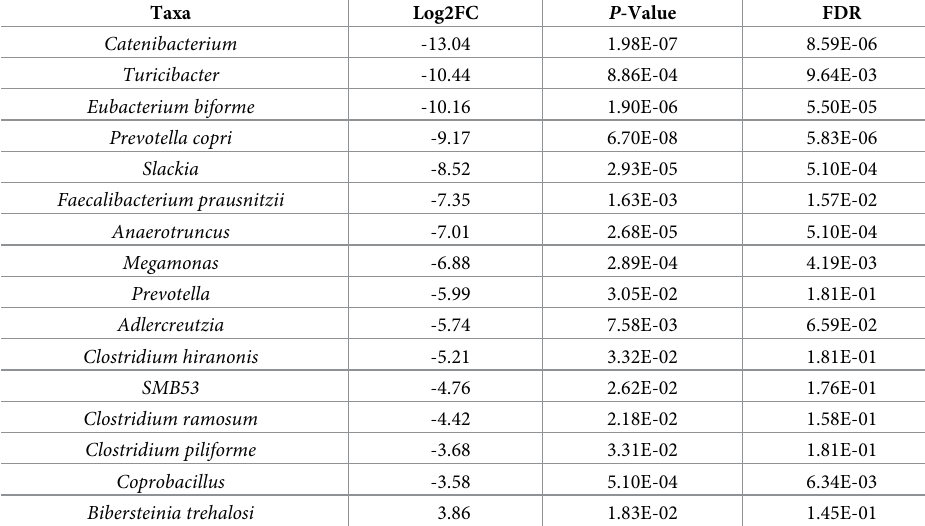
Table 3. Significant changes in taxa at admission (AHDS vs donors).